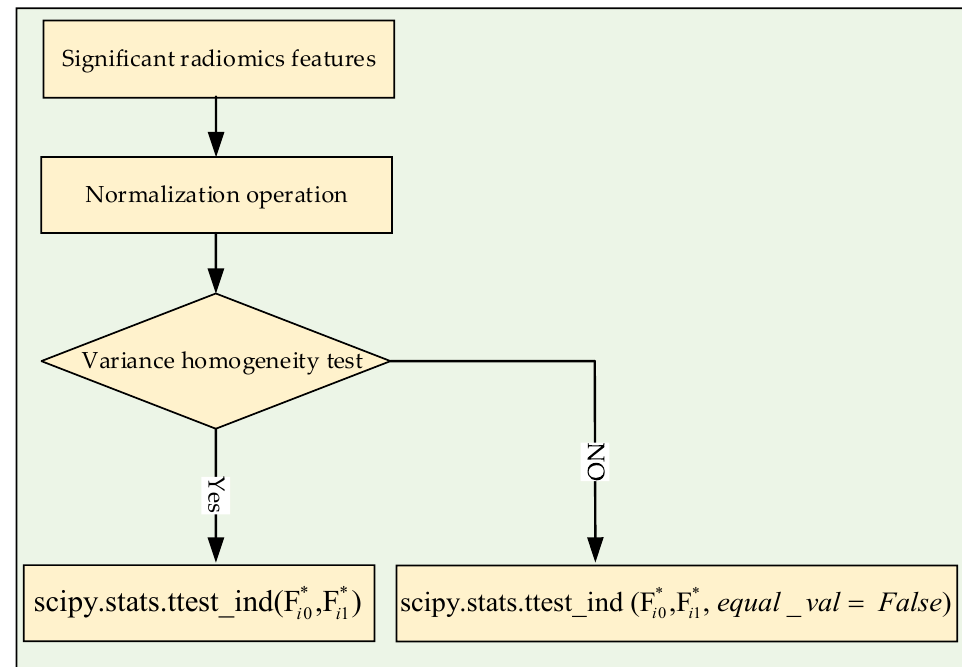
* F and F are the i th feature in LT and NT and F ∗ are the i th feature in LT and NT i 0 i 1 1 i 0 i